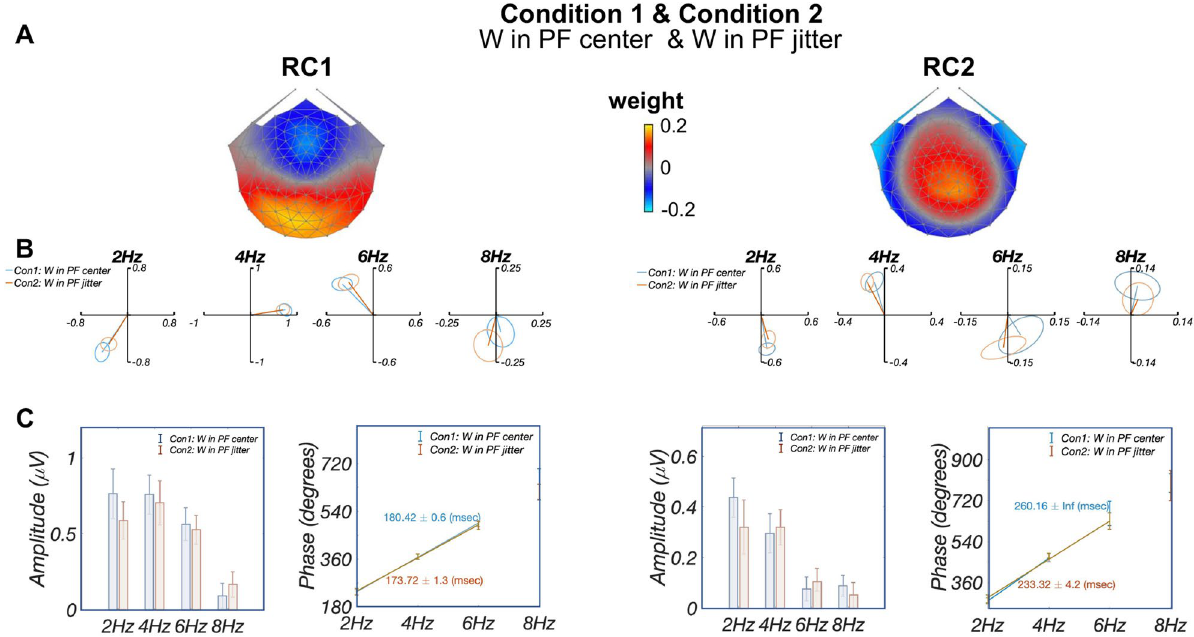
Figure 4. Deviant analysis: visual word form processing responses are similar irrespective of stimulus location. RCA was trained on response data from conditions 1 and 2 together as their RCs were highly similar when trained separately. ( A ) Topographic visualizations of the spatial filters for the first two components (RC1 and RC2); ( B ) Response data in the complex plane, with condition 1 (W in PF center) in blue and condition 2 (W in PF jitter) in red. Amplitude (vector length) and phase (vector angle, counterclockwise from 0 radians at 3 o’clock direction) overlap across conditions especially at significant harmonics (first three harmonics in RC1 and RC2). Ellipses indicate standard error of the mean; ( C ) Comparison of projected amplitude (left) and latency estimation (right) between two conditions. Response amplitudes did not differ significantly across the four harmonics ( p > 0.65 ); latency estimations derived from phase slopes across significant harmonics were also similar between conditions (RC1: 180.42 ms and 173.72 ms for conditions 1 and 2 respectively; RC2: 260.16 ms and 233.32 ms for conditions 1 and 2 respectively). Figures were created using publicly available